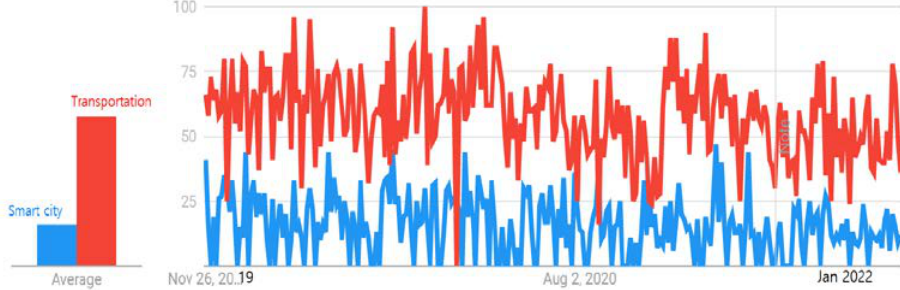
Figure 6. Comparison between number of projects in a smart city and transportation in South Korea (2018–2022). Source: Google Trends https://trends.google.com/trends/explore (accessed on 22 December 2022) [35].